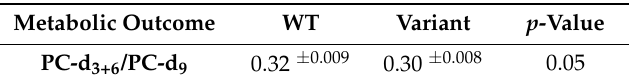
Table 10. PEMT rs4646343 genotype alters plasma choline PC-d3+6/PC-d9 enrichment ratios. Values are least-squared means ± standard errors for each group. Values are ratios.